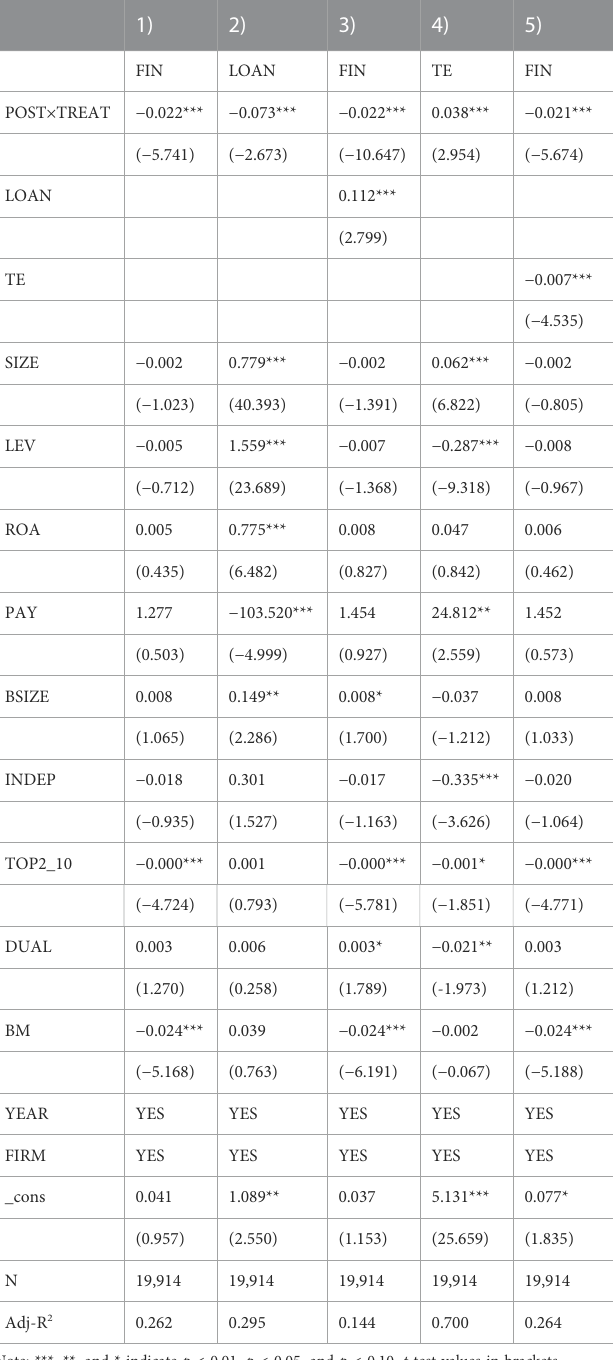
TABLE 10 Mediation: Loan constraints and the number of patents granted for inventions.